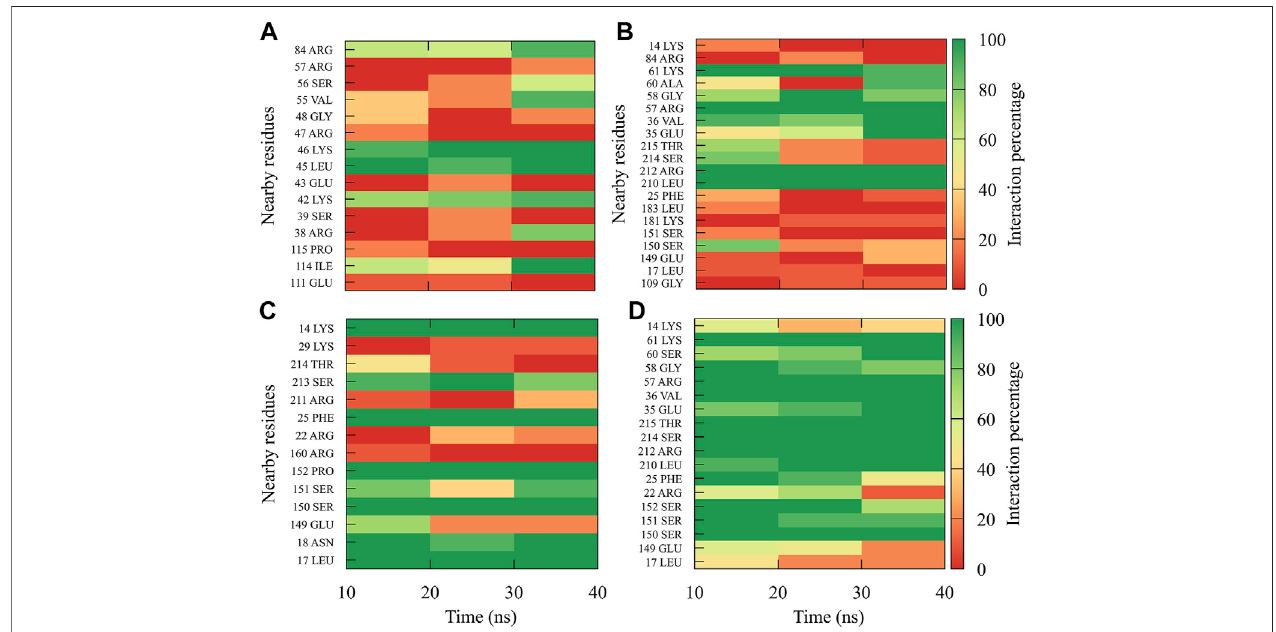
FIGURE 5 | Contact frequency maps for the compound 1md , bound to the GTP-binding site of the (A) DENV1, (B) DENV2, (C) DENV3, and (D) DENV4. Red represents that the contact frequency was 0%, while green represents that the contact frequency was 100%.